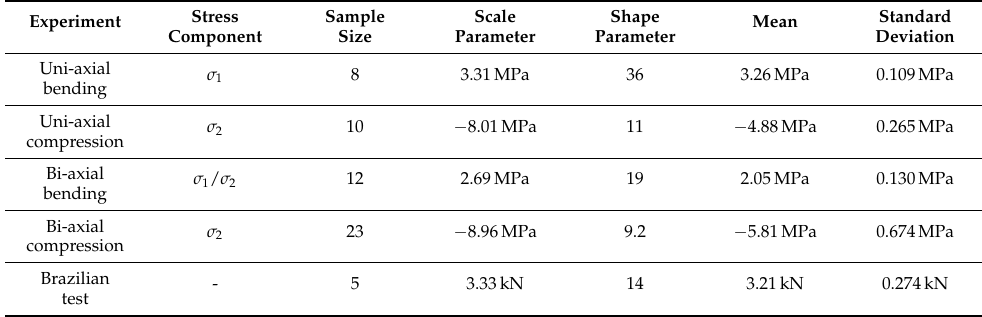
Table 1. Data collection and statistical evaluation of the performed